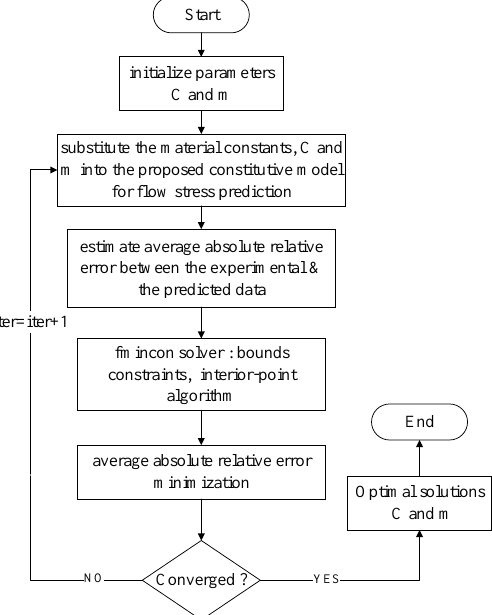
(cid:104) (cid:105) and ln T ∗ under the reference conditions. 1 − σ ( A + B ε n )